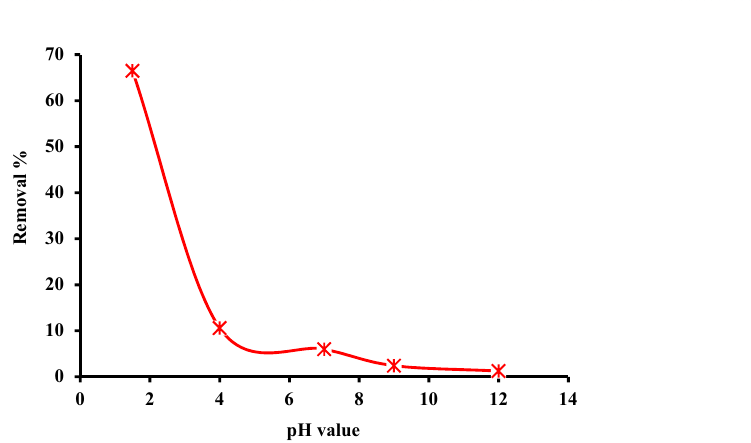
Figure 5. The thermogravimetric curves of the MP and MBT using TGA and DTA.